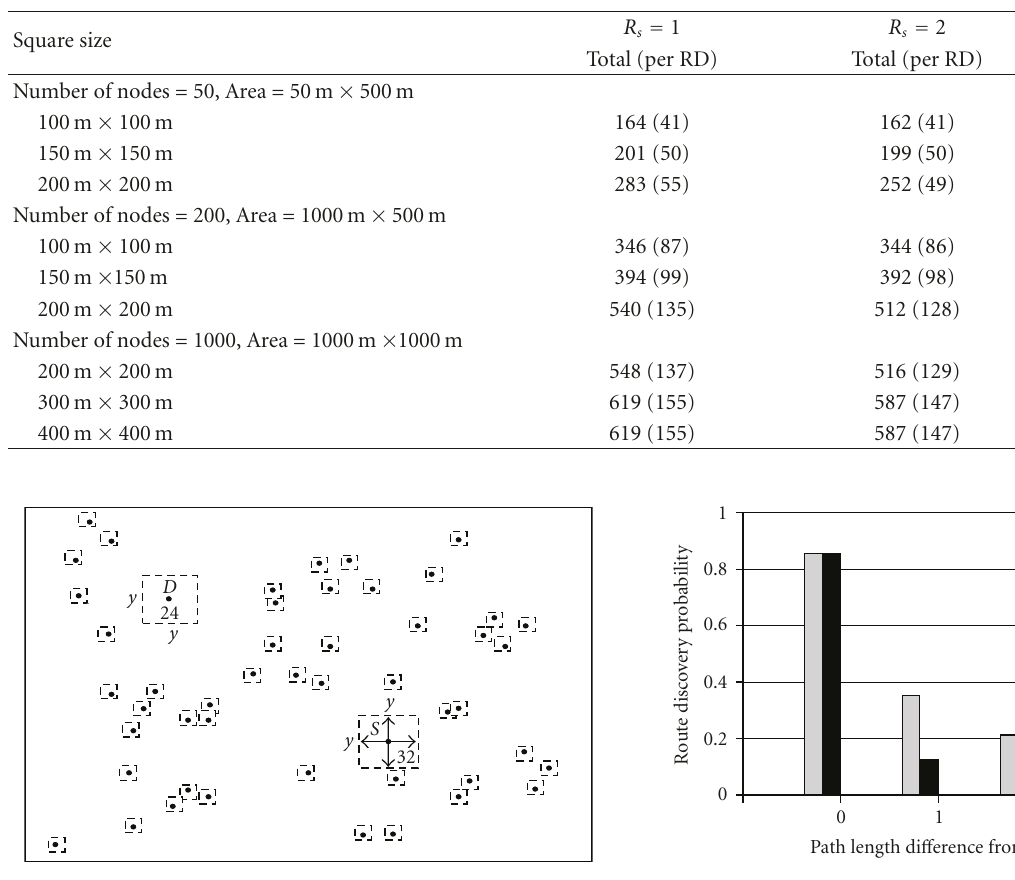
Figure 4: Example illustration of mobile scenarios.